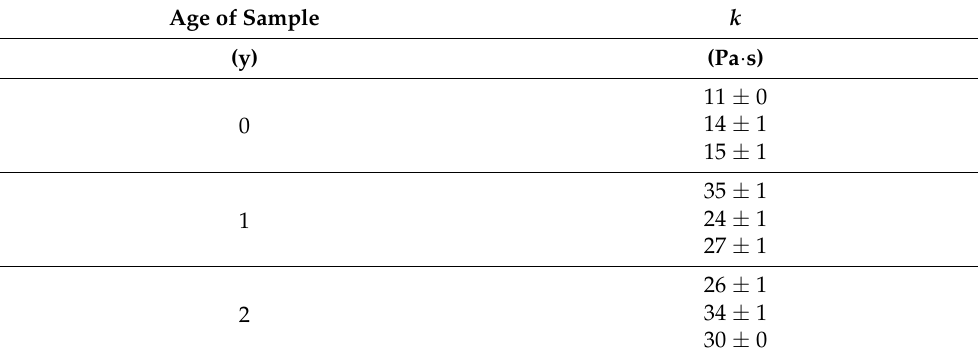
Table 4. Herschel–Bulkley consistency indices after high-rate (10,000 s − 1 ) shearing. Age of